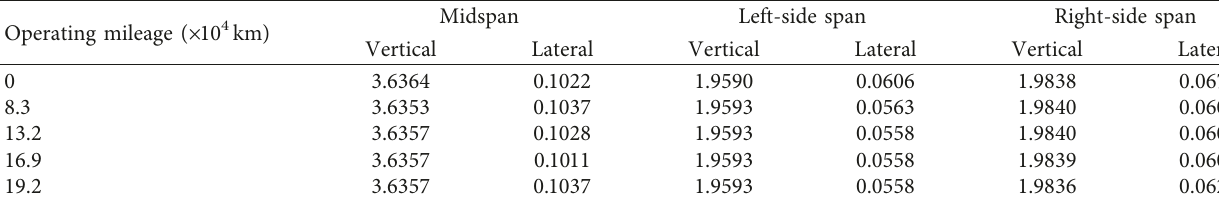
Figure 26: Peak values of bridge accelerations: (a) vertical acceleration of midspan; (b) lateral acceleration of midspan; (c) vertical acceleration of left-side span; (d) lateral acceleration of left-side span; (e) vertical acceleration of right-side span; (f) lateral acceleration of right-side span. Table 2: The peak values of bridge